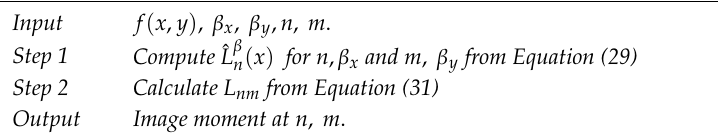
Algorithm 3: Generalized Laguerre Orthogonal Moments (GLMs)